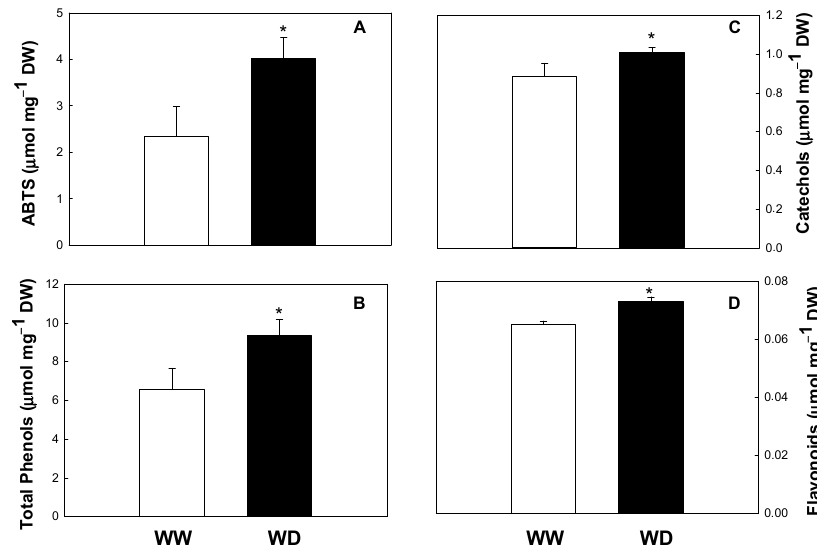
Figure 1. Total antioxidant activity evaluated by the ABTS assay (A), total phenolic content (B), catechols (C), and flavonoids (D) in well - watered (WW) and water - deficit (WD) plants of Melia azedarach . Values are means ± standard deviation ( n = 6). Asterisks indicate statistical differences between treatments ( p < 0.05). Table 1. Melia azedarach leaf metabolite content (mg g − 1 DW) in plants under in well-watered (WW) and water-deficit (WD) conditions. Values are means ± standard deviation ( n = 3). For each line, asterisks indicate statistical differences between treatments ( p < 0.05). Fold change (log 2 (WD/WW)) in metabolites after WD treatment (values of the fold change are presented near the respective bar). Rt-retention time, DW-dry weight.